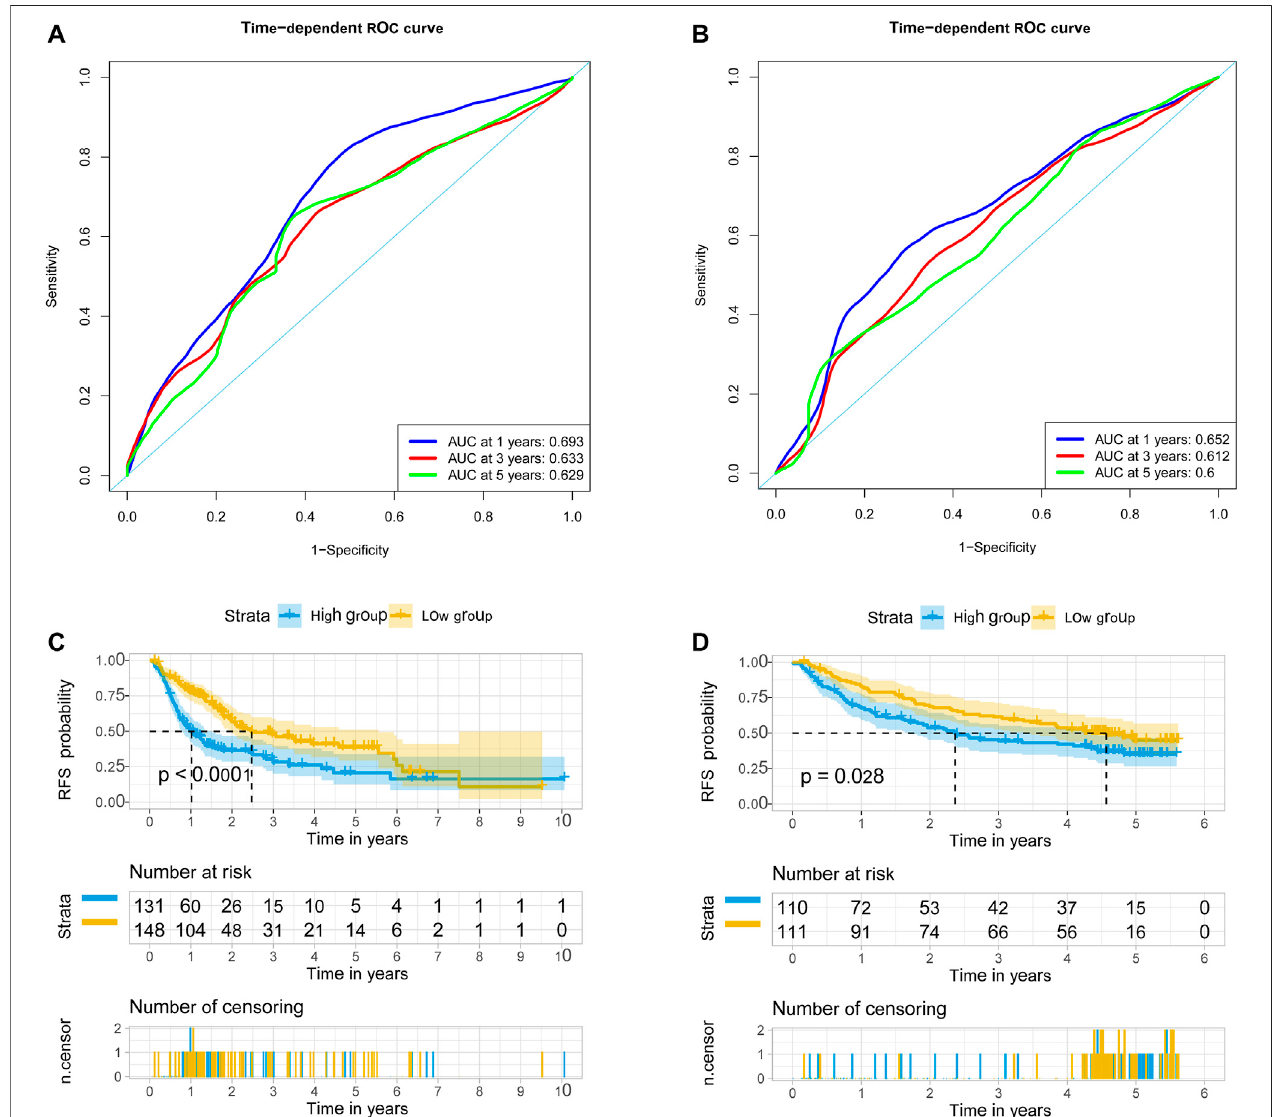
FIGURE 6 | EMT-correlated gene signature associated with HCC patient ’ s recurrence-free survival. (A) . The predictive value of EMT risk score for predicting the RFS of HCC patients in TCGA dataset. (B) The predictive value of EMT risk score for predicting the RFS of HCC patients in the GSE14520 dataset. (C) The recurrence- freesurvivalbetweenthehighEMTriskscoregroupand thelowEMTriskscoregroupintheTCGA HCC cohort. (D) .Therecurrence-free survivalbetweenthehighEMT riskscoregroup andthe lowEMTriskscoregroup intheGSE14520 HCC cohort. Notes: EMT,Epithelial-mesenchymaltransition;HCC, hepatocellular carcinoma; RFS, recurrence-free survival; TCGA, The Cancer Genome Atlas